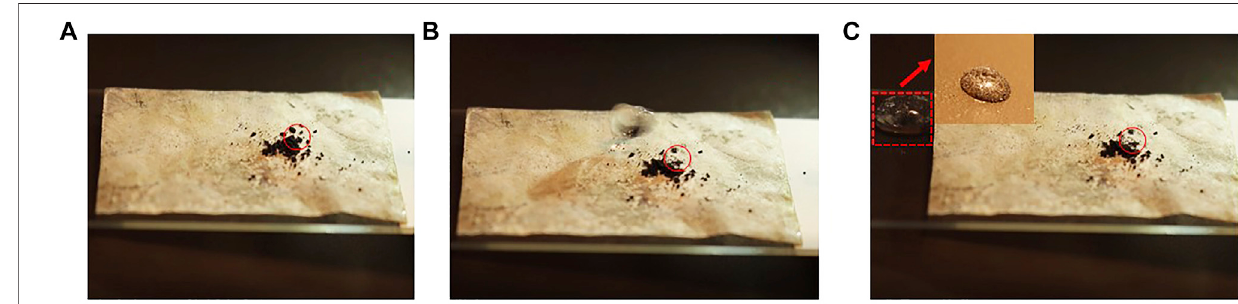
FIGURE 8 | Self-cleaning test CNF/PVA/PDA.